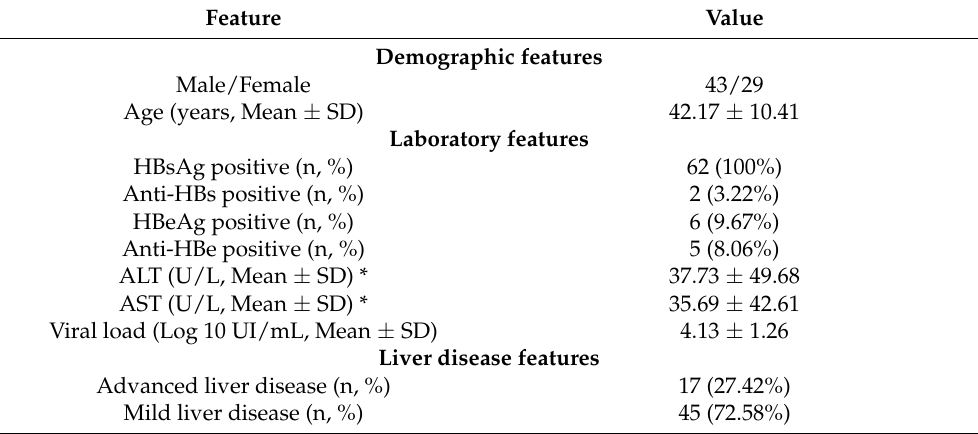
Table 1. Demographic, laboratory and clinical characteristics of